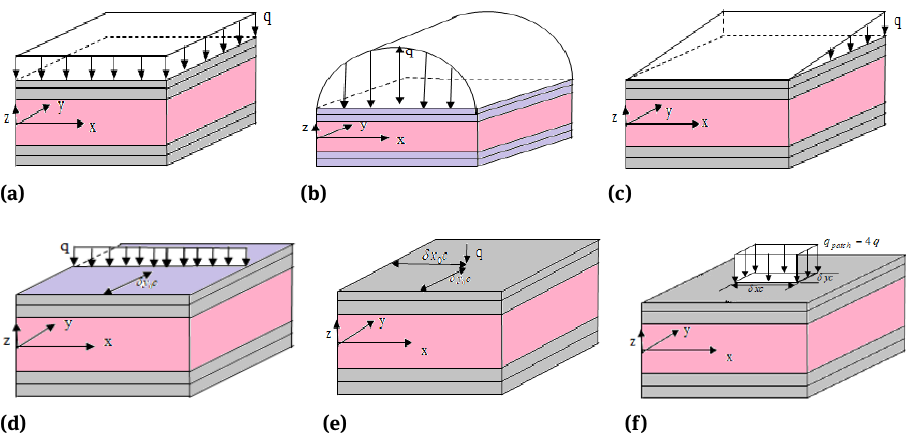
Figure 3: Effect of various types of loading on the sandwich plate for (a) uniformly distributed loading; (b) sinusoidal loading; (c) hydrostatic loading; (d) line loading; (e) point loadings; (f) patch